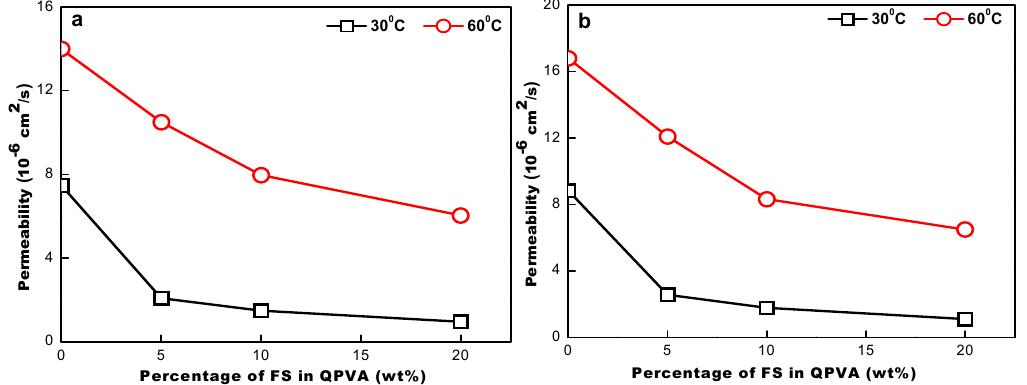
Figure 7. Ethanol permeabilities of QPVA, QPVA/5% FS, QPVA/10% FS and QPVA/20% FS at ( a ) 3 M and ( b ) 5 M ethanol concentrations at 30 °C and 60 °C.